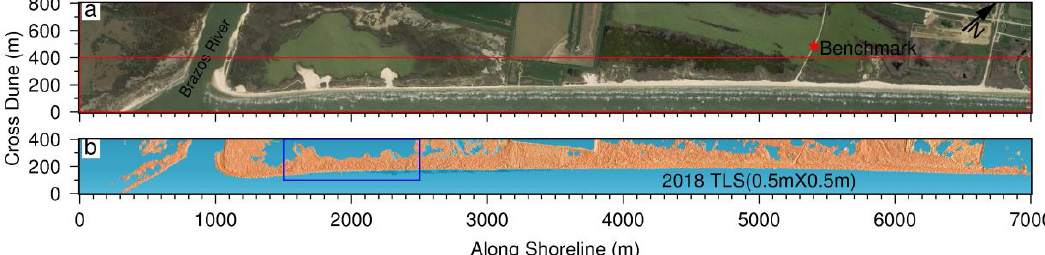
Figure 3. ( a ) A Google Earth image showing the beach – dune – wetland area in Freeport, Texas; ( b ) hill- shaded bare earth topographic map derived from TLS datasets collected in May 2018. The coordinate system for the image and point clouds was rotated 40 degrees counter-clockwise for better demonstration. The red star is the location of the U.S. Geological Survey (USGS) permanent benchmark. The blue rectangle indicates the area for evaluating the performance of the rapid surveying method.